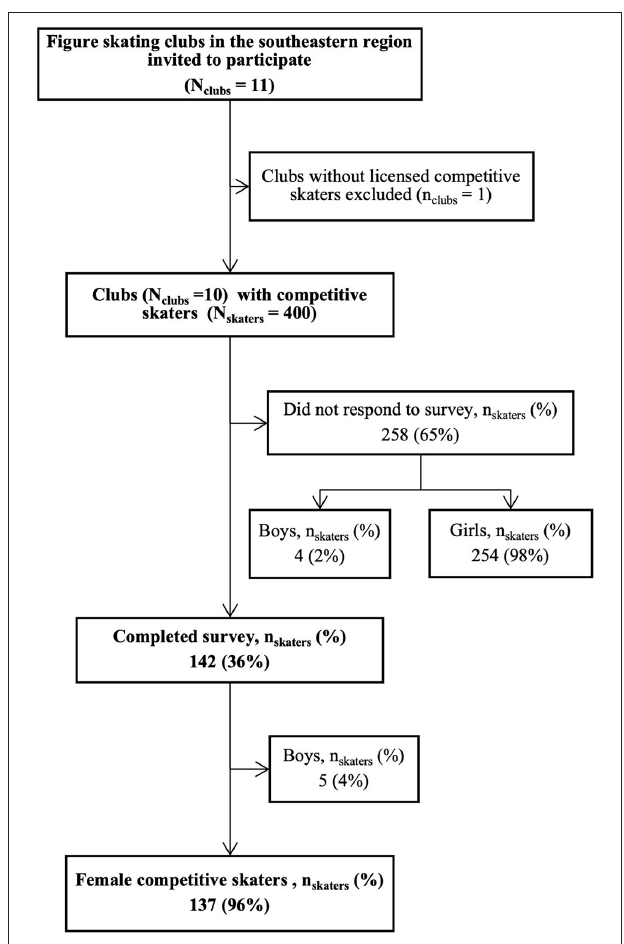
FIGURE 2 | Study recruitment flow chart.